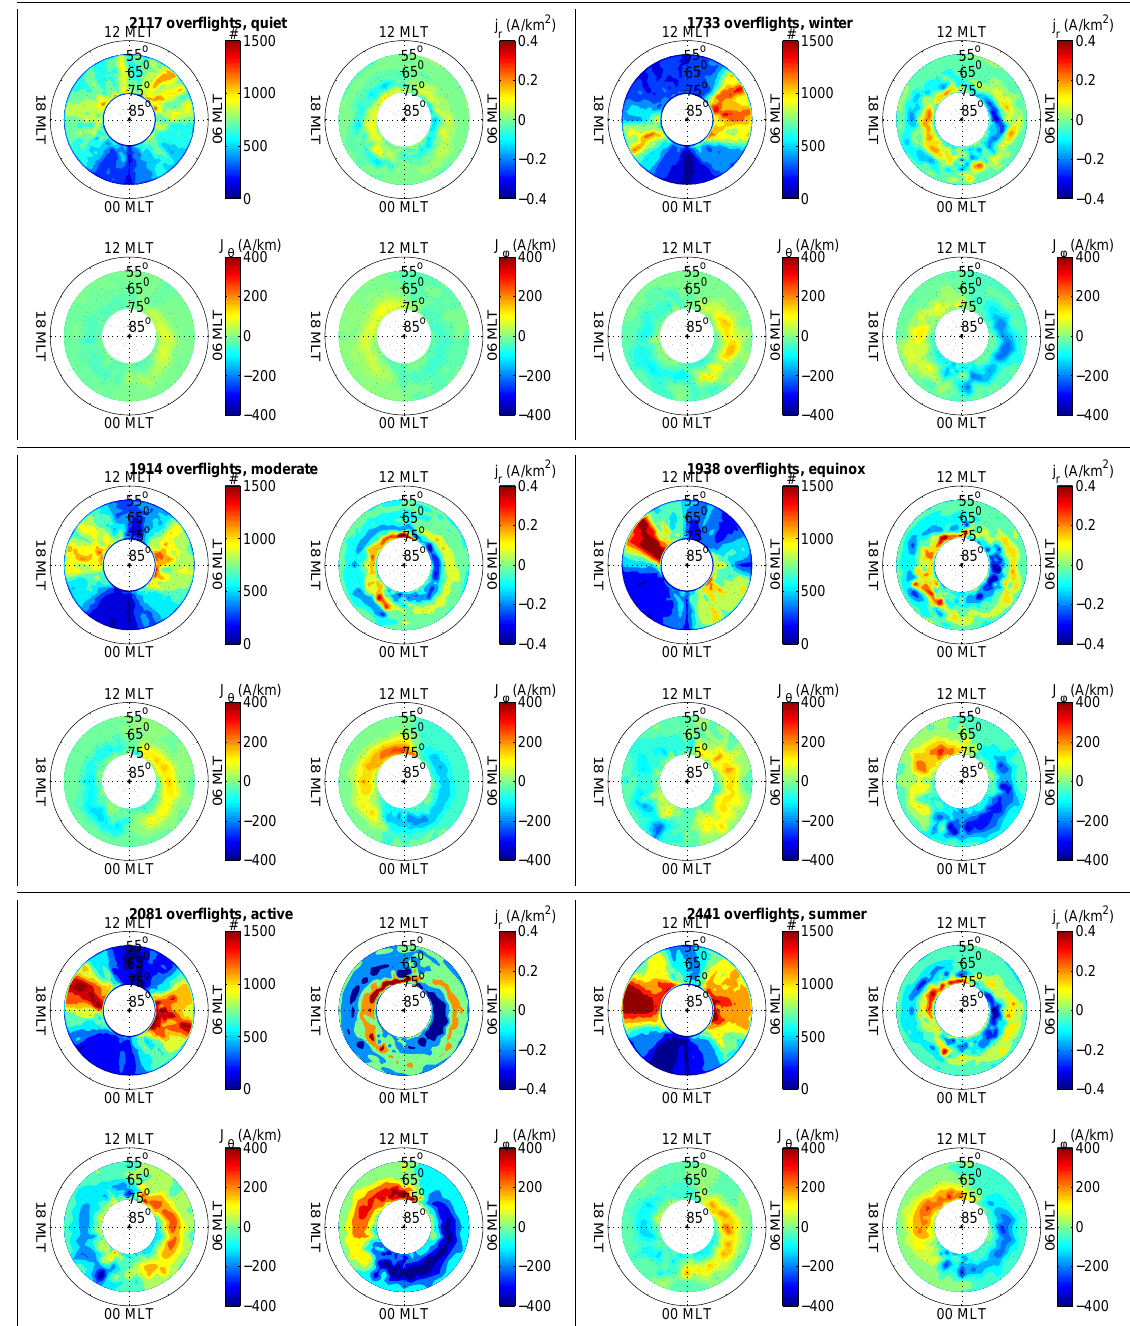
Fig. 11. The same as Fig. 10 except that the data are binned with respect to activity and season. The bin and the number of overpasses used to construct the four plots are denoted on top of each set. The plots in the left hand side column show the binning with respect to activity (quiet: | I φ | < 0 . 15MA, moderate: 0 . 15 ≤| I φ | < 0 . 30MA, and active: | I φ |≥ 0 . 30MA) and the plots in the right hand side column with respect to season (winter, equinox, and